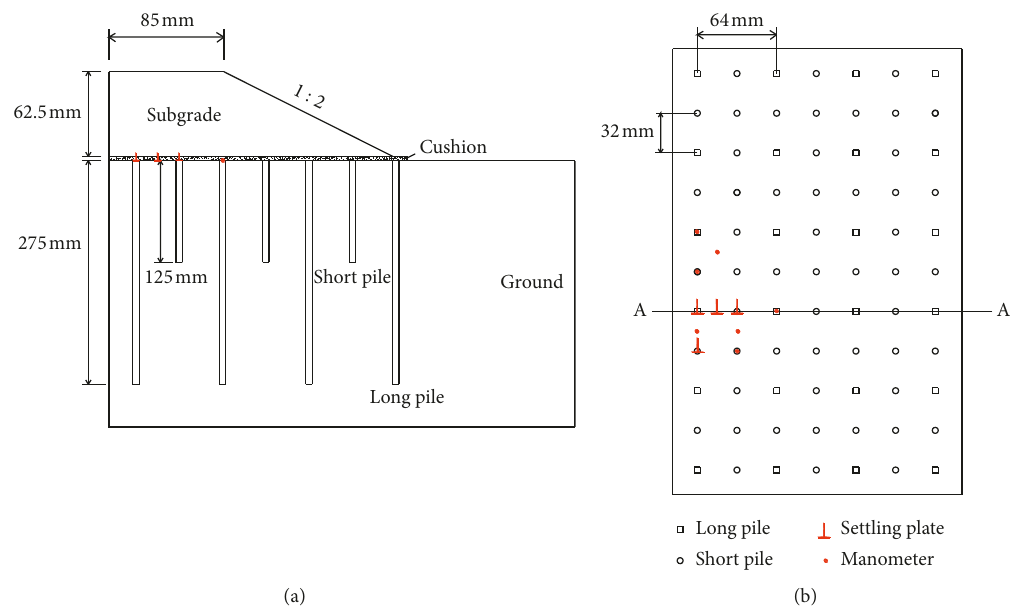
Figure 4: The specific test model and instrument layout. (a) A-A sectional view. (b) Top